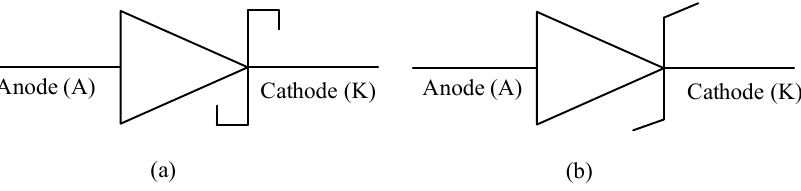
Figure 4. Schematic of ( a ) a schottky diode and ( b ) a zener diode [95].